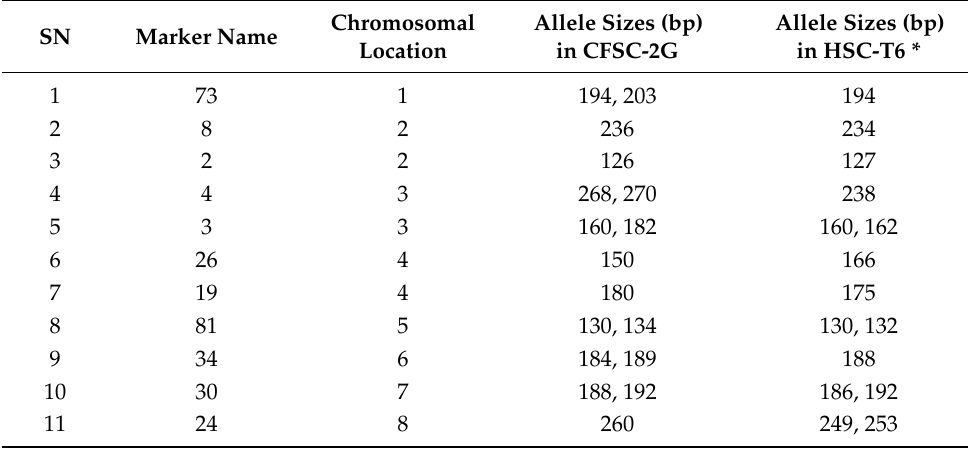
Table 4. STR profile of CFSC-2G using the 31 species-specific STR